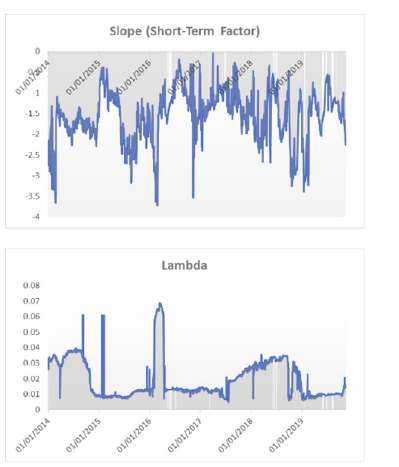
Fig. 1 . Model 1 result (level, slope & curvature)